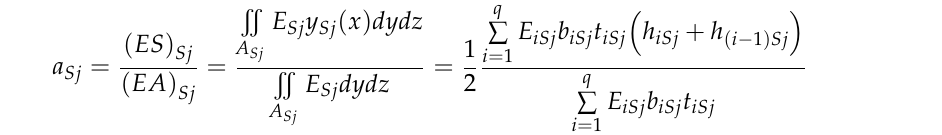
( R o ) of the pVEH microdevice equivalent resonator.